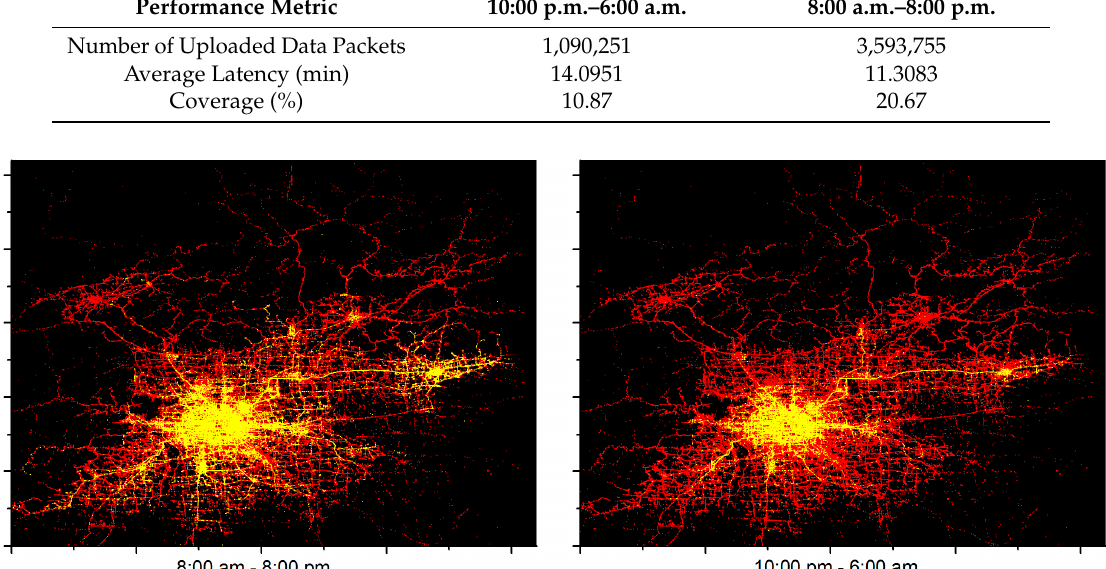
Table 5. Experimental results at different time in one day.